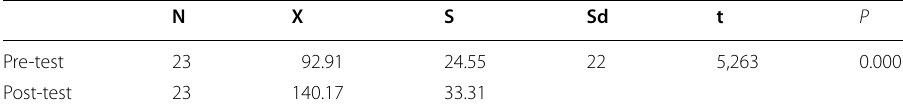
Table 1 T-test analysis results of students’ TCTT pre-test and post-test scores N X